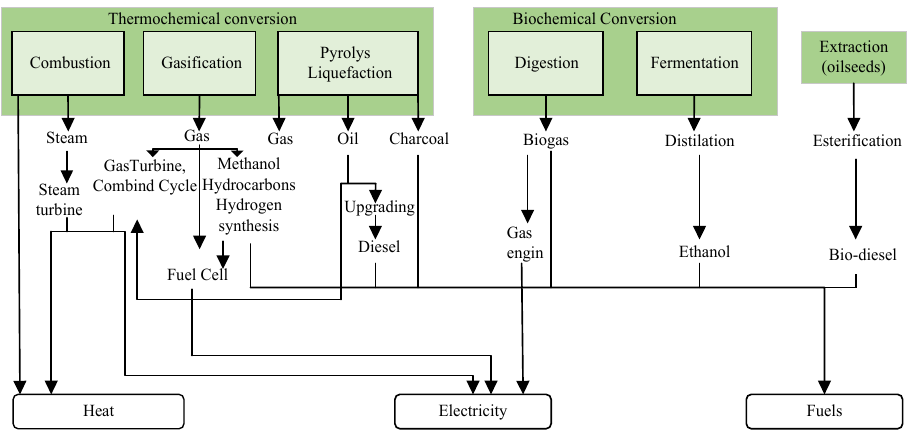
Figure 9. Scheme of technologies for converting biomass to energy.